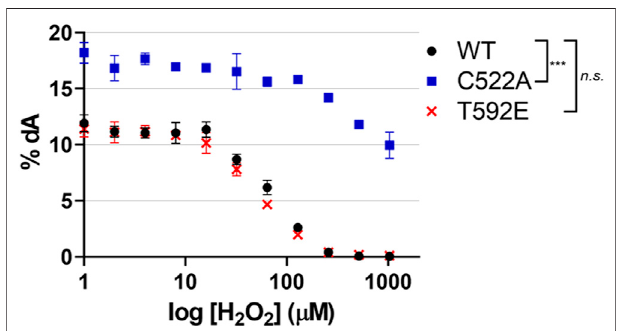
FIGURE 3 | SAMHD1 T592E is catalytically active and sensitive to oxidation. Catalytic activity was of SAMHD1 wild-type, T592E, and C522A were measured in vitro as a function of increasing hydrogen peroxide concentrations. The T592E variant shows nearly identical activity and sensitivity to peroxide inhibition as wild-type protein. As a control, the C522A SAMHD1, which is insensitive to oxidation, remains active even at high concentrations of peroxide. Activity was determined by the percentage of dATP that was converted to the product dA. Hydrogen peroxide concentration is presented on a logarithmic scale. The mean of three independent experiments are plotted, error bars represent standard error of the mean (SEM). Data were normalized to WT at 0 µM H 2 O 2 for analysis and p